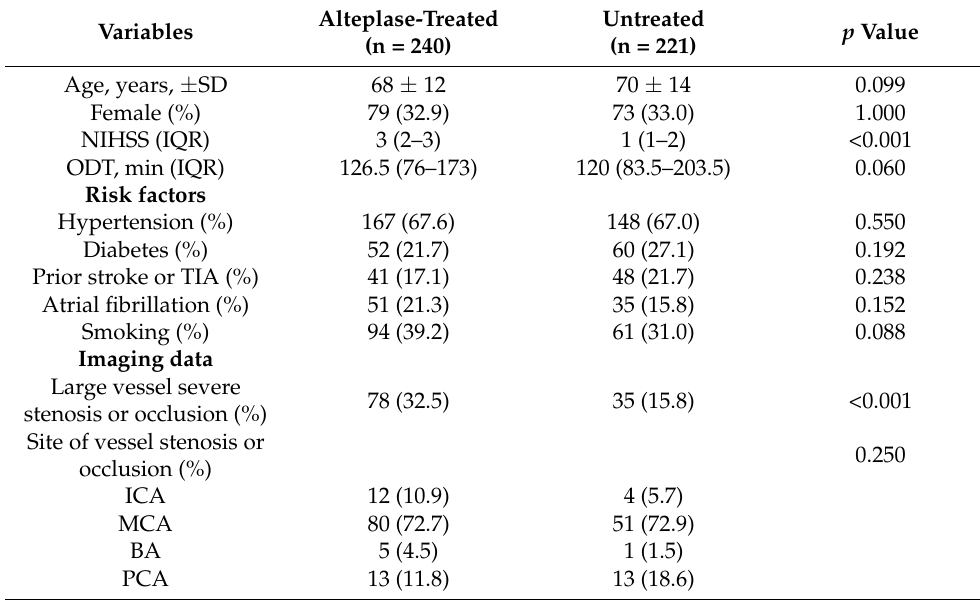
Table 1. Univariate comparison of characteristics in alteplase-treated and untreated groups in patients with minor non-disabling acute ischemic